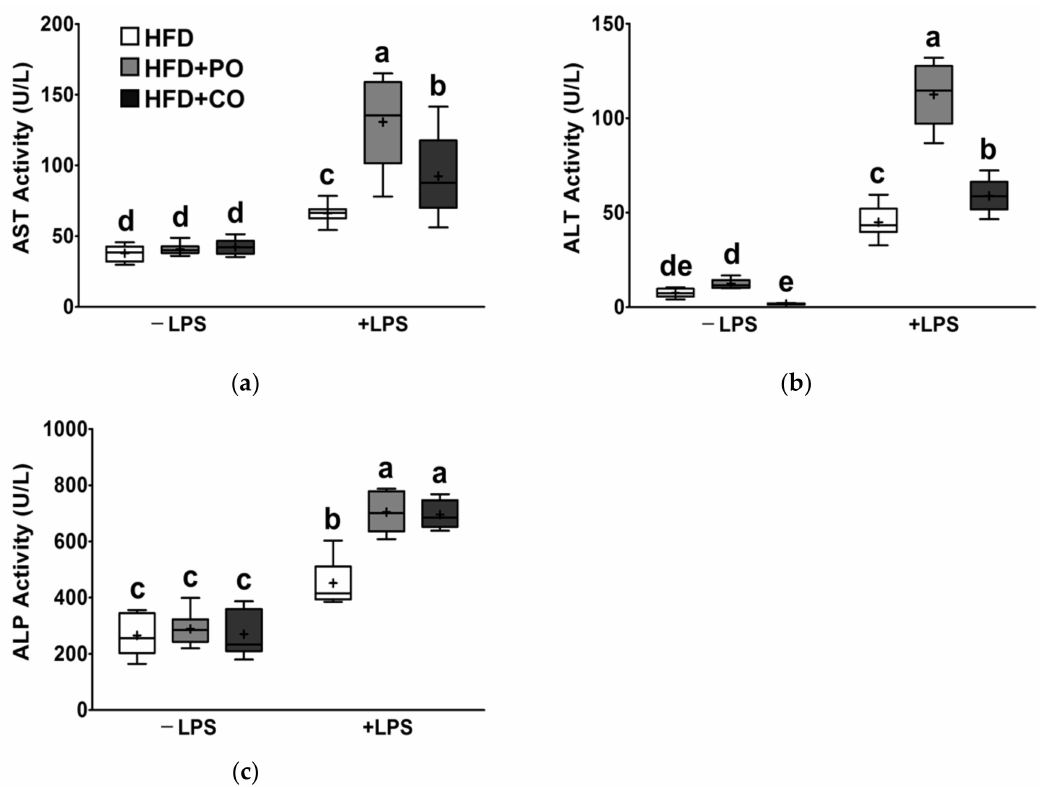
Figure 5. Effects of partial replacement of dietary fat with PO or CO and LPS stimulation on liver function parameters in serum. Five-week-old male Sprague-Dawley rats were fed either the HFD, HFD + PO, or HFD + CO for 12 weeks and then treated with PBS or LPS (5 mg/kg) for 24 h ( n = 8 per group). ( a ) Aspartate aminotransferase (AST) activity; ( b ) alanine aminotransferase (ALT) activity; ( c ) alkaline phosphatase (ALP) activity. Data were analyzed using two-way ANOVA and Tukey’s multiple comparisons post hoc test for multiple comparisons. Means with different letters indicate significant differences at p < 0.05. LPS, lipopolysaccharide; PBS, phosphate-buffered